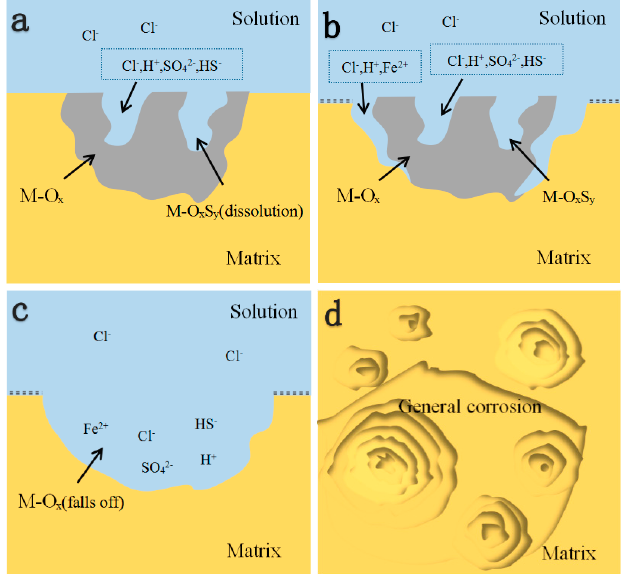
Figure 12. Schematic diagram of the corrosion process of RE microalloyed steels from pitting nucleation ( a ), to pitting growth ( b , c ), further to the propagation of general corrosion ( d ).